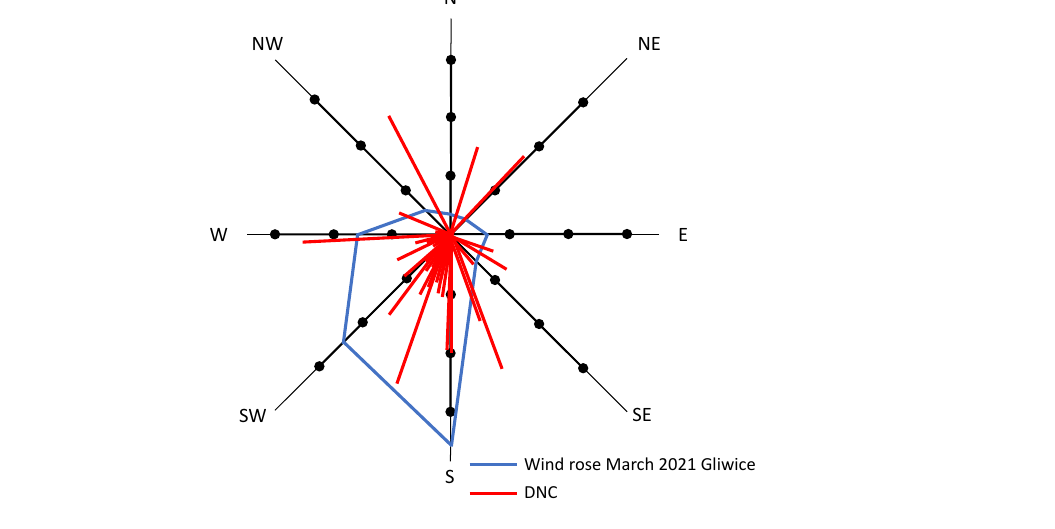
Figure 5. Wind rose vs. daily new cases (DNCs).